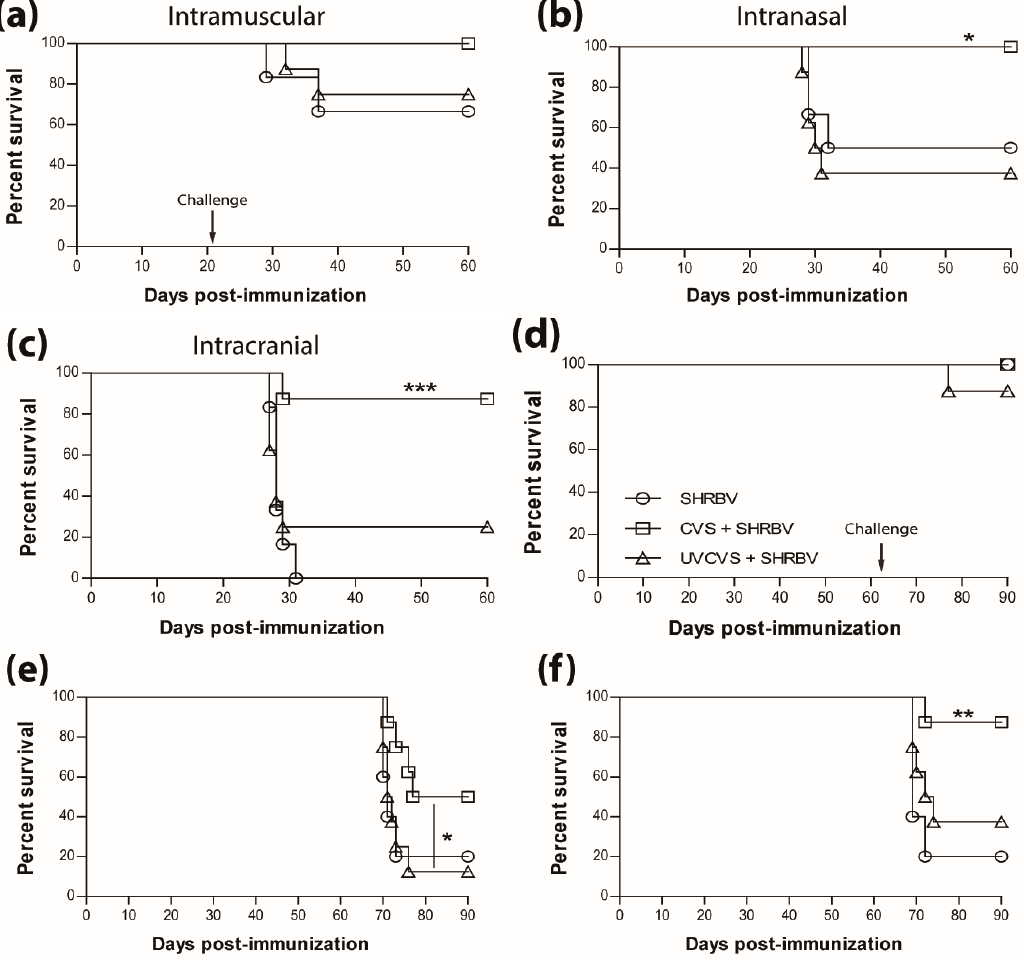
Figure 4. Single immunization with live-attenuated vaccine confer superior long-lasting protection against wild-type virus challenge. Swiss Webster mice were either mock-immunized or immunized with 1 × 10 5 f.f.u. of live-attenuated CVS-F3 or 1 × 10 8 f.f.u. of inactivated CVS-F3 (UV-CVS-F3) then challenged 21 (top row) or 63 (bottom row) days later with 1 × 10 4 f.f.u. of SHBRV-17 virus and monitored for survival. Data are expressed as percent survival ( n = 10 per group). Animals were immunized either ( a and d ) intramuscularly in the gastrocnemius, ( b and e ) intranasally or ( c and f ) intracranially, then challenged with the corresponding route. Statistically significant differences between groups are denoted as follows: * p ≤ 0.01; *** p ≤ 0.001.